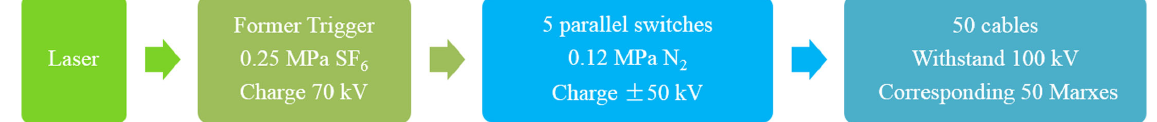
FIG. 13. Diagram of the repetitive multipath trigger system.